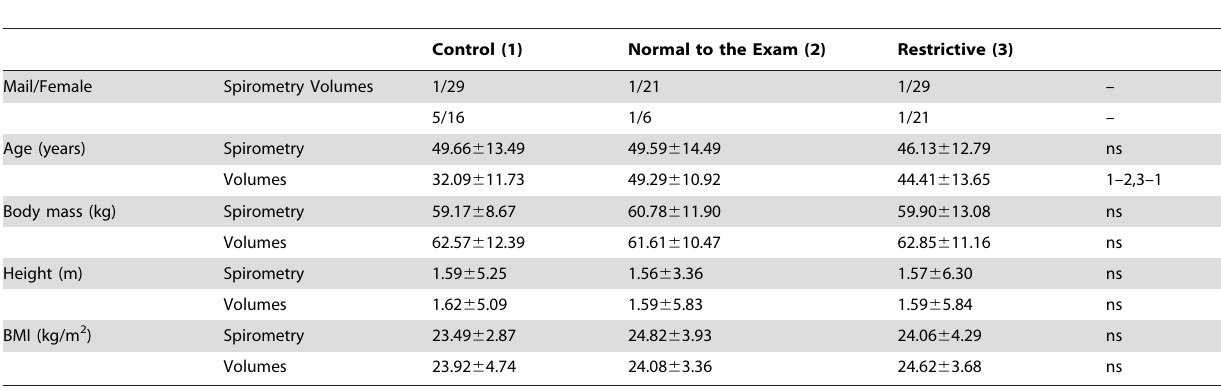
Table 1. Anthropometric characteristics of the studied subjects in the analysis using spirometry and pulmonary volumes as a reference.